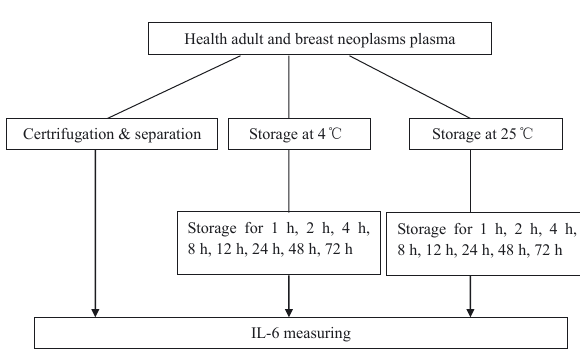
Figure 1: Pre-analytical settings and handling procedures.